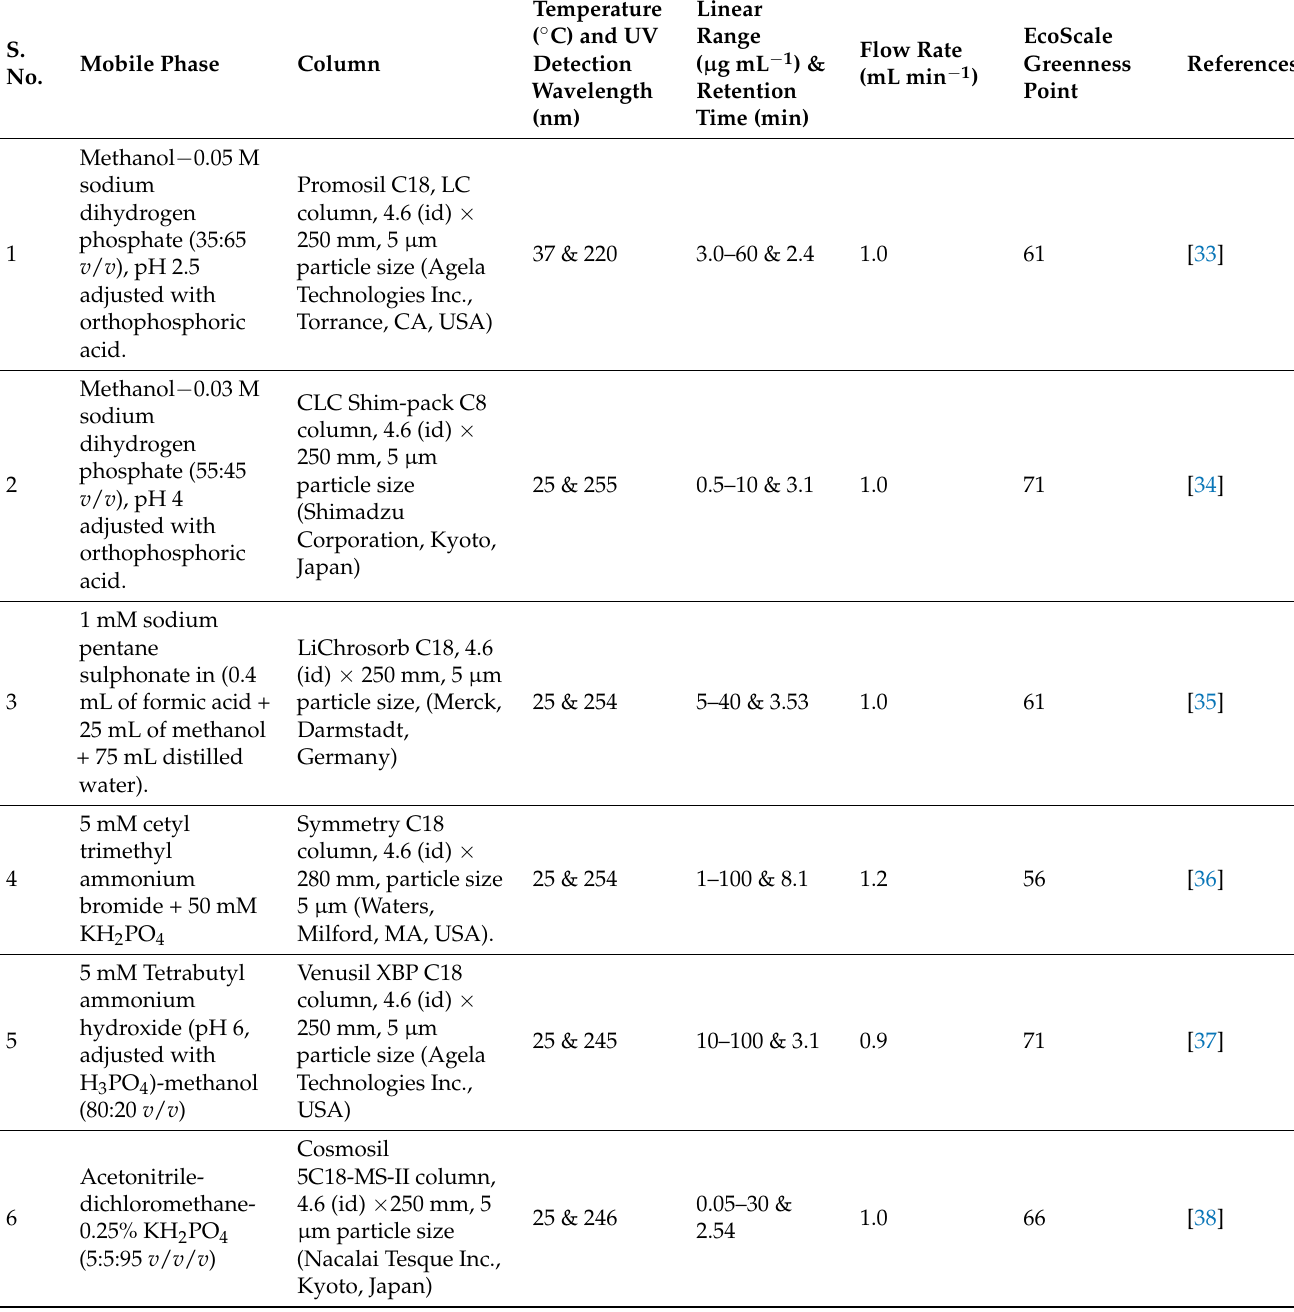
Table 9. Performances of the proposed HPLC method and other published HPLC methods for determination of ascorbic